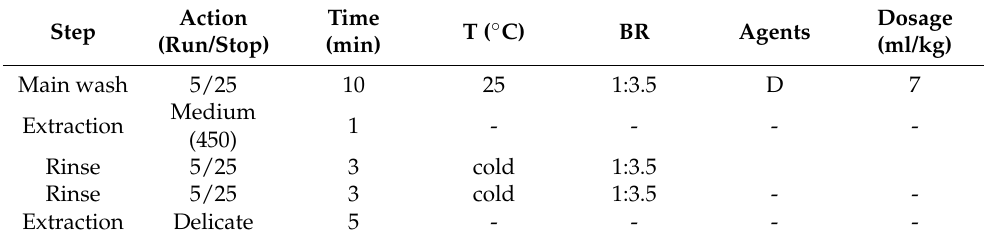
Table 3. Wet cleaning (W) of PES/CO/SS fabric.